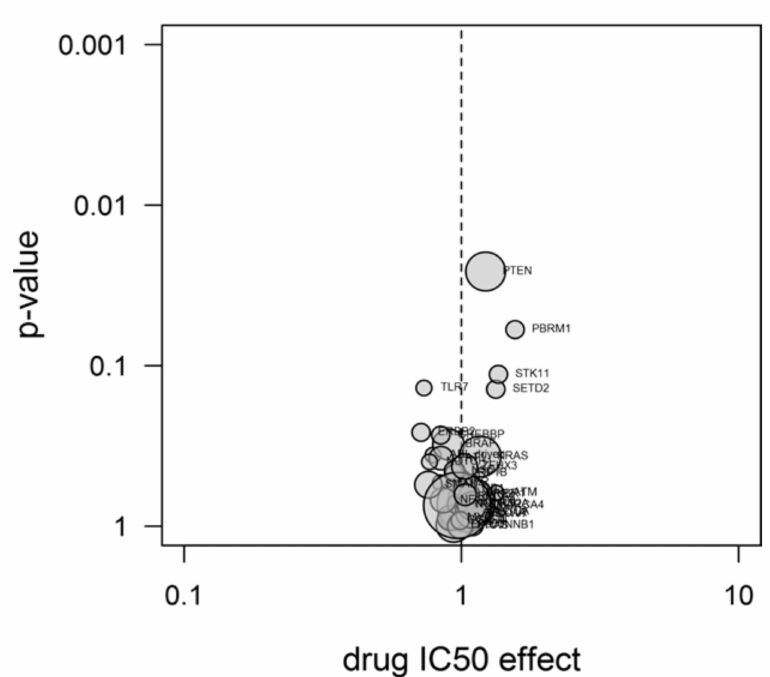
Figure 6. Volcano plot reporting the ANOVA analysis performed over thirty-nine cancer genes, including TLR7. The x -axis represents the factor of IC 50 shift, while the y-axis reports the p-values, i.e., the confidence level for genetic association of mutations in a particular gene with a IC 50 shift. The areas in the circles are proportional to the number of mutants present in the cell panel (each reported gene was present in at least three Oncolines TM cell